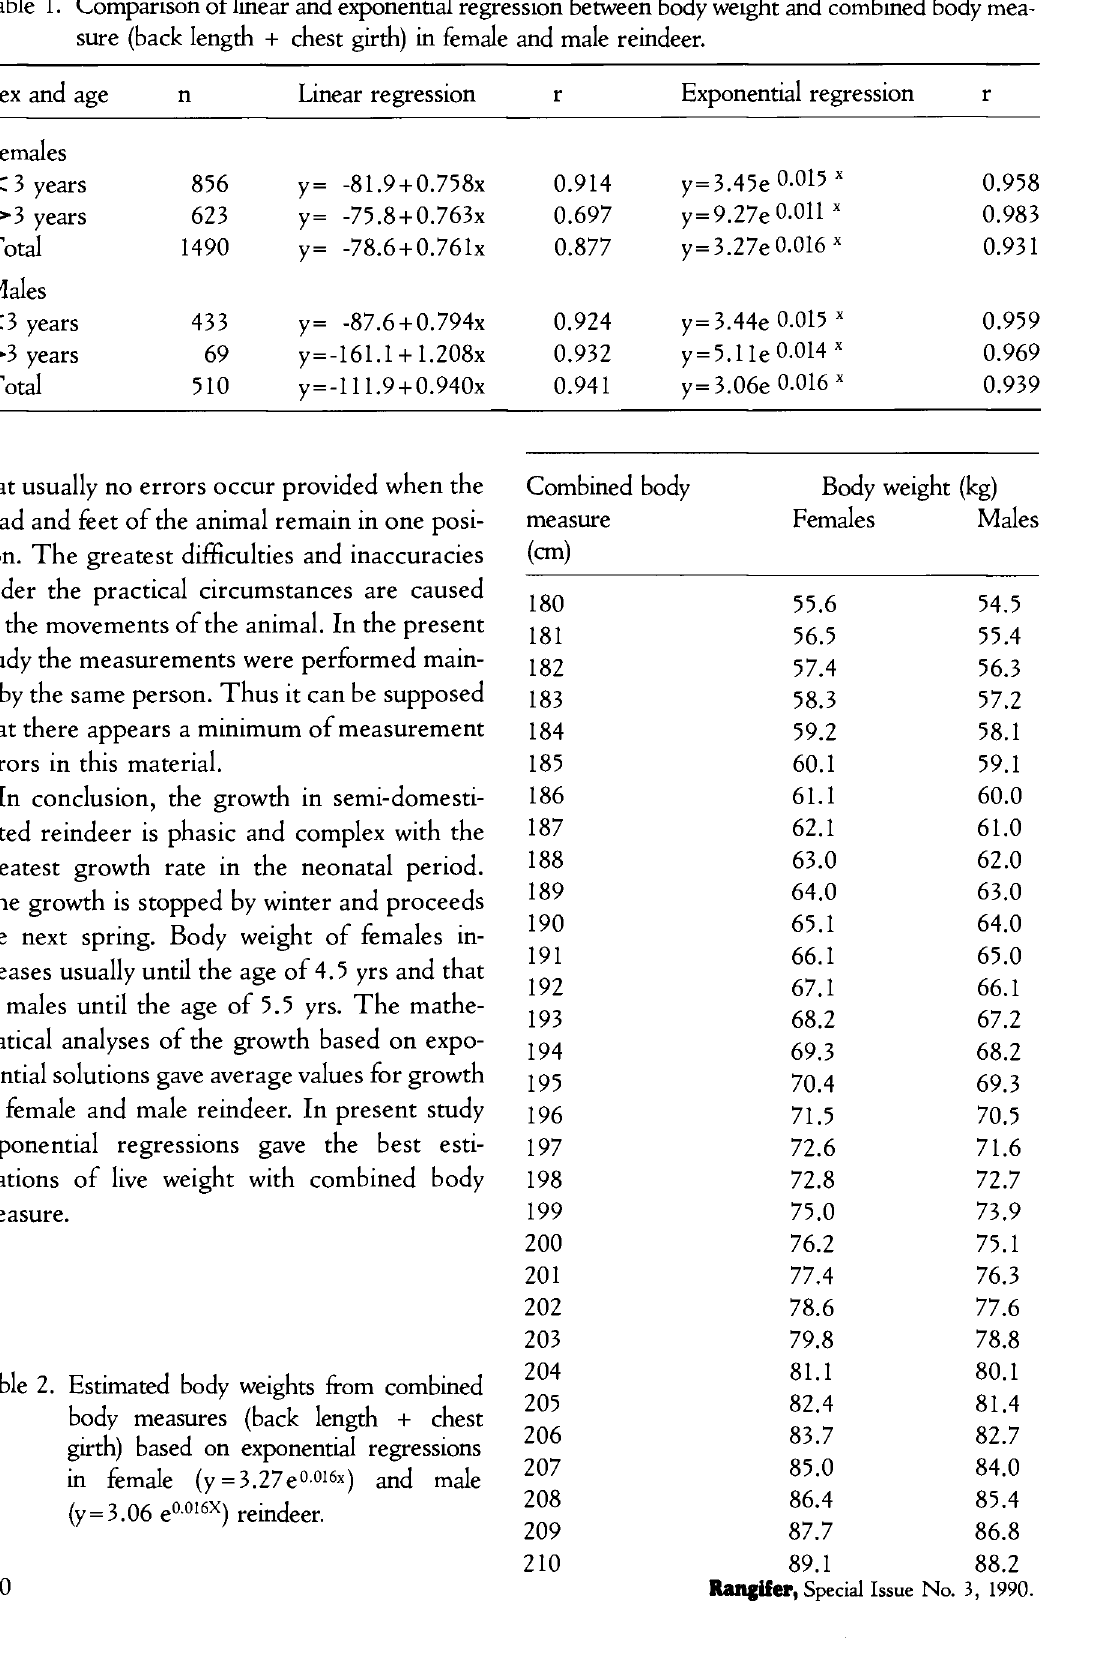
Table 1. Comparison of linear and exponential regression between body weight and combined body mea sure (back length + chest girth) in female and male reindeer.